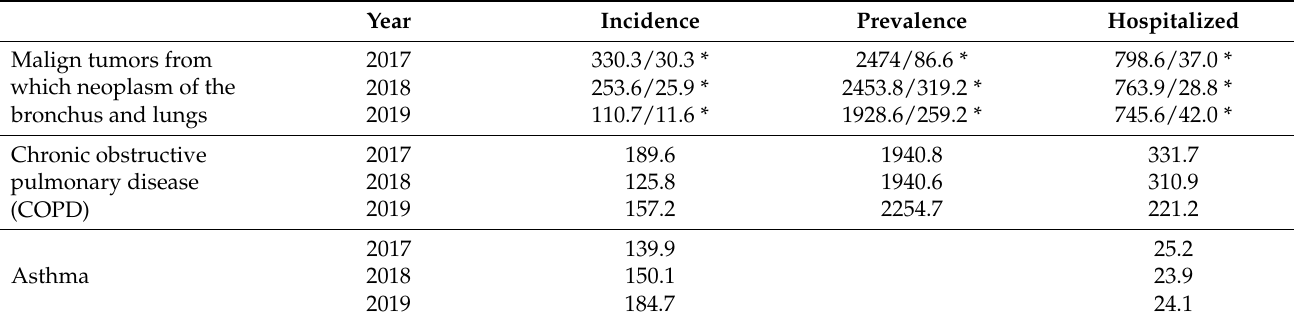
Table 4. Morbidity for Brasov County per 100,000 habitants according to INSP data. Year Incidence Prevalence